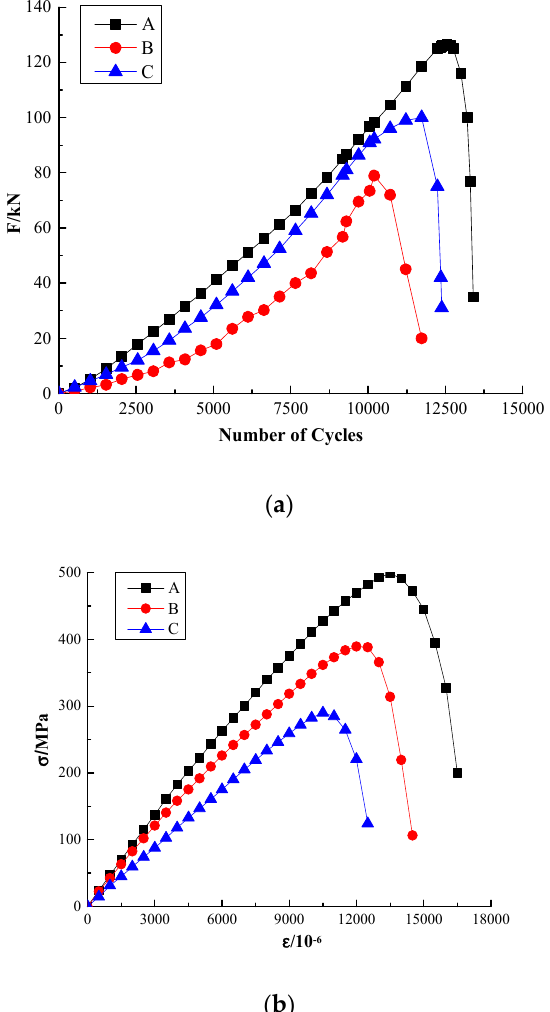
Figure 4. Fatigue experimental results: ( a ) load-number of cycles curve; ( b ) stress-strain curve.